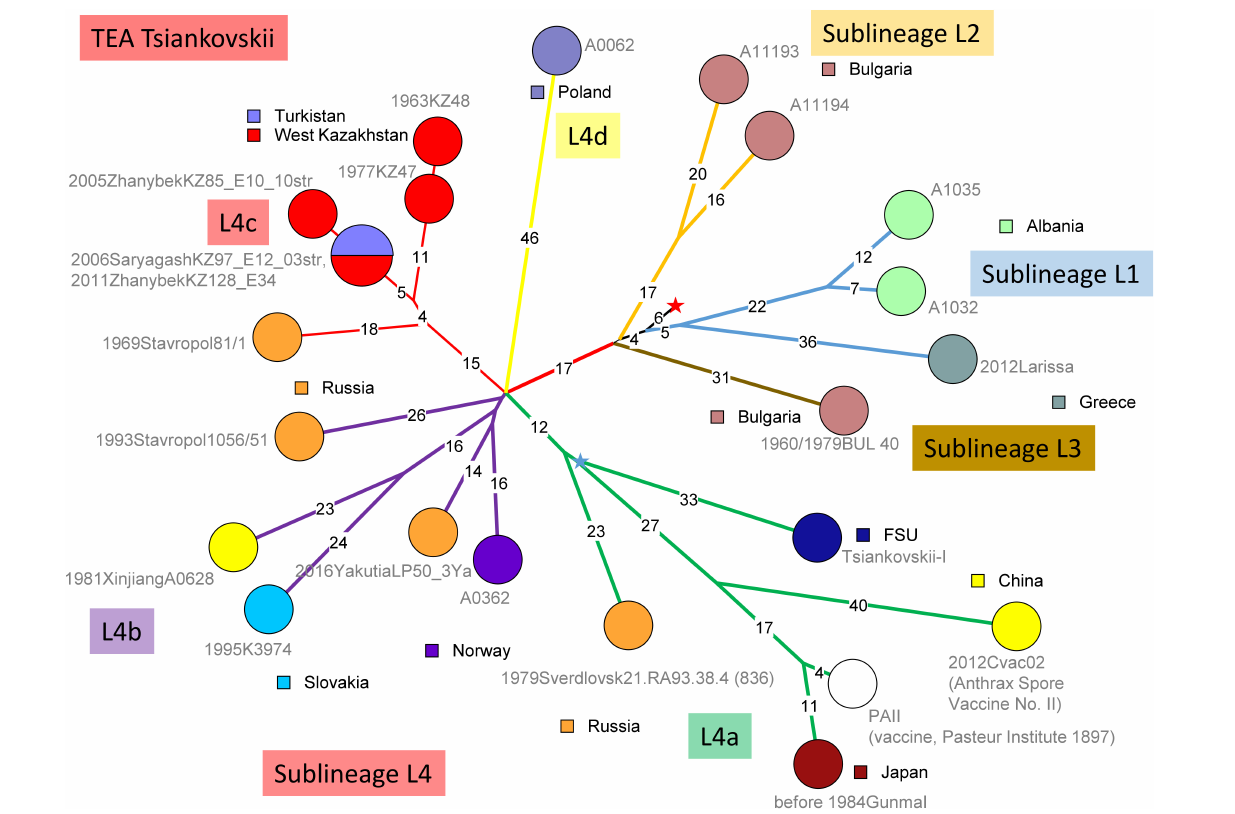
FIGURE 3 | wgSNP analysis of strains assigned to TEA clade “Tsiankovskii.” Maximum parsimony analysis. 587 SNPs in tree, tree size 588 (homoplasia 0.17%). Branch lengths of three SNPs and more are indicated, a linear scale was used. Each strain is labeled with year of isolation, geographic origin, strain Id, event number when context information is available, number of associated strains when above one. Color code reflects the geographic origin of the strains. The red star indicates the position of the root (MRCA) of the TEA polytomy. Four deep-branching sublineages are defined. The four-branches polytomy within sublineage 4 are lettered [“a” to “d”; strain 506-55 (Eremenko et al., 2021) may constitute a fifth branch]. Branches are colored accordingly. Branch L4a contains the Tsiankovskii-I vaccine strain itself. The Tsiankovskii-I vaccine strain was developed in 1883 (Marinin et al., 2008; World Health Organization [WHO], 2008). Tsenkovsky developed the vaccine in Kharkov, in the then-Russian Ukraine (Fedotova, 2012). Branch L4a contains additional vaccine strains, PAII used in Japan (Okutani et al., 2019) and Cvac02 used in China (Zhou et al., 2015). The topology of branch L4a strongly suggests that PAII and Cvac02 are both derived from the Tsiankovskii vaccine. The blue star reflects the position of an hypothetical Tsiankovskii-I ancestor strain (the MRCA of the vaccine associated branches). The weaponized Sverdlovsk strain (Sahl et al., 2016) is branching two SNPs prior to this MRCA. Branch L4b represented by five independent strains, is predominantly European, with one exception from Western China. It contains two strains recovered from high latitudes, one in Norway and the other from Yakutia, Siberia (Timofeev et al., 2019). Nine strains from Eremenko et al. (2021) can be assigned to this branch. Branch L4c is present in the Stavropol area and in West Kazakhstan. Ten strains from Eremenko et al. (2021), including published Stavropol strain 81/1 belong to Tsiankovskii branch L4c. These strains constitute a polytomy with four branches (Eremenko et al., 2021). The strains from Kazakhstan branch out from one of these four branches. The most parsimonious interpretation of the observed topology is the introduction of a single lineage from Southern Russia to West Kazakhstan. Finally, lineage L4d is represented by a single strain from Poland. Two strains from Republic of Moldova (strains 802-263 and 575-122) might also belong to Tsiankovskii L4d according to the published list of SNPs (Eremenko et al., 2021).